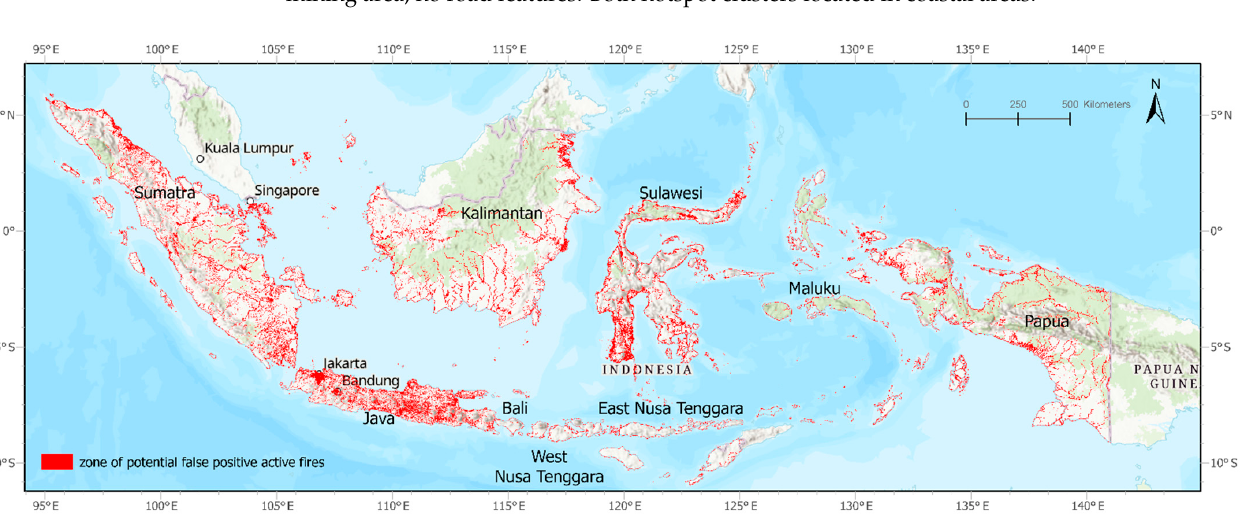
Figure 7. Zone map of potential false-positive active fires for biomass burning from low-spatial- resolution data.